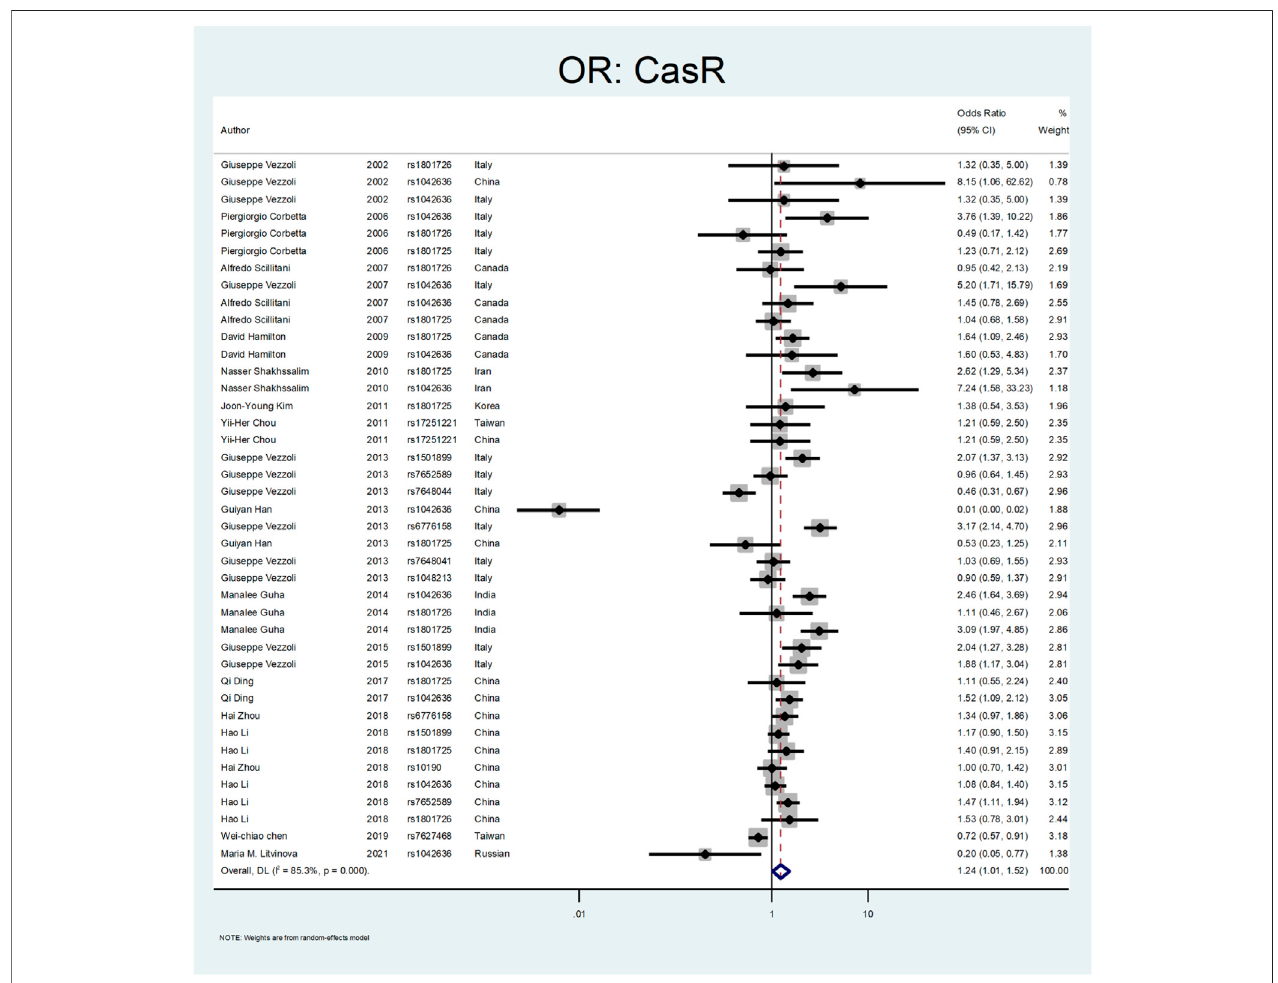
FIGURE 5 | Forest plot: OR for